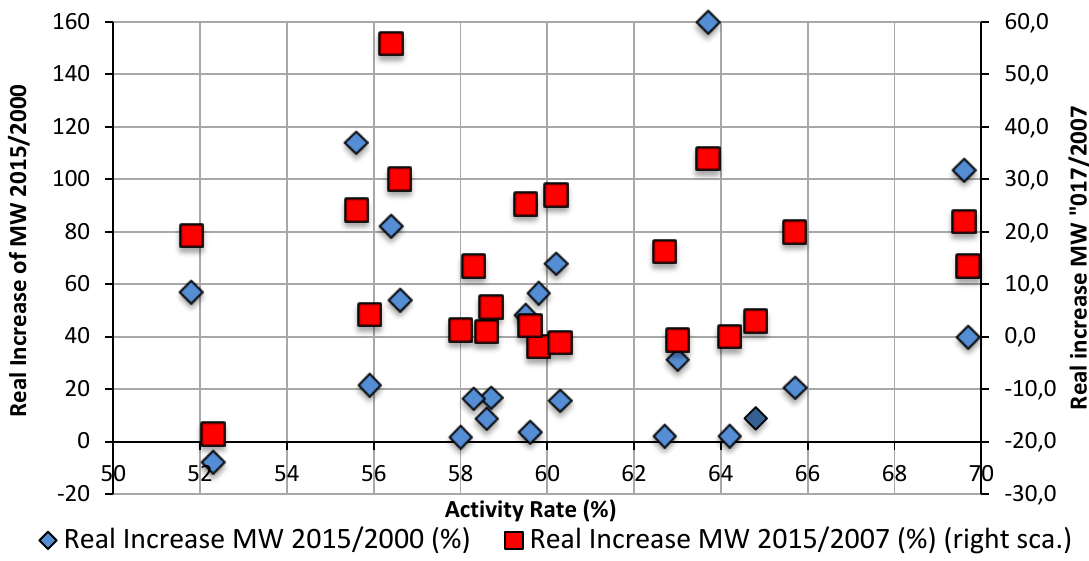
Figure 4. Real Increase of the Minimum Wage (2015/2000 and 2015/2007) and Activity Rate (%)in OECD countries. Source: Own elaboration in basis to OECD